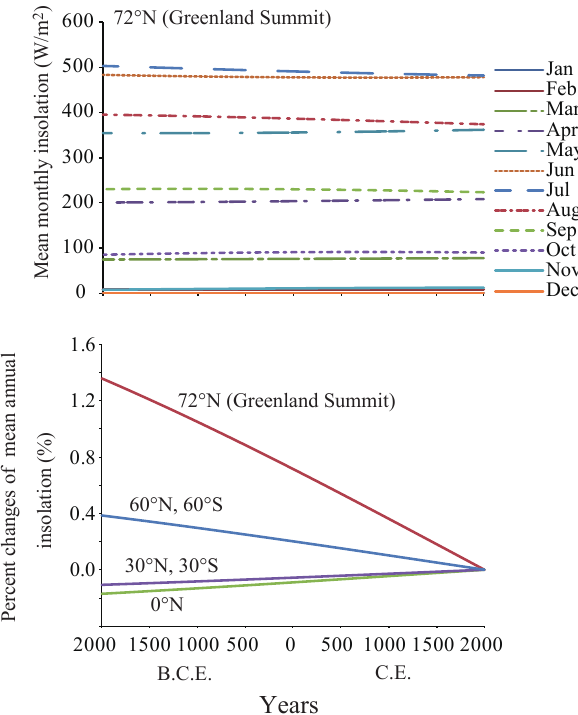
Fig. 4. Changes in orbital forcing at 72 ◦ N and various latitudes over the past 4000yr. Top panel: mean monthly average insolation. Months are defined from the calendar days 21–20 (e.g. January is from 21 December to 20 January). Note that December and January have no insolation. Bottom panel: percent change of annual solar insolation from present in various latitudes over the past 4000yr. Present mean annual insolation at 72 ◦ N is 192.8Wm − 2 . Data are from Laskar et al.